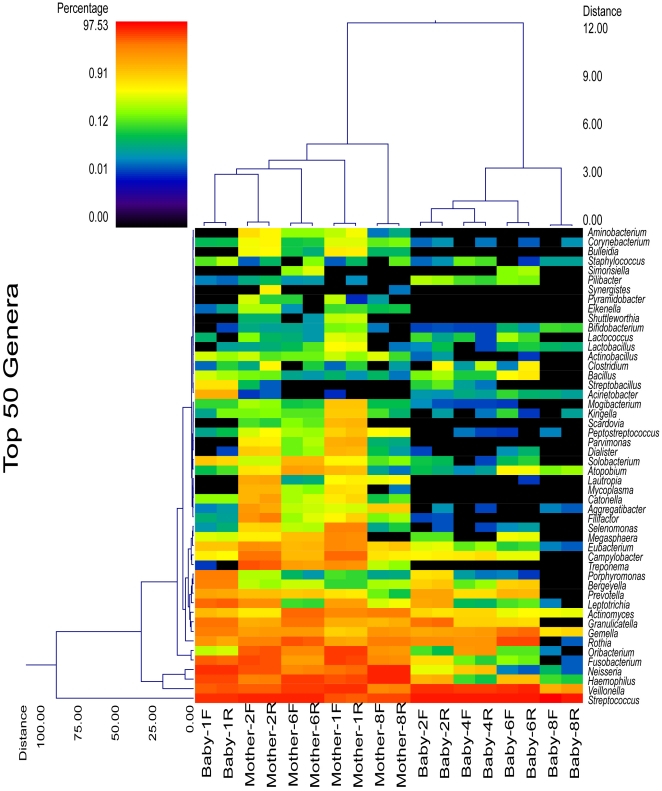
Dual hierarchical clustering dendogram of the most predominant and ubiquitous 50 bacterial genera among the samples.Baby and mother number and sequence direction [forward (F); reverse(R)] are provided on the bottom x-axis. Those genera that occurred in only 1 sample were omitted, along with those present in relative average percentages<0.09% in 3 or fewer samples. The genera that occurred in average percentages <0.01% among all samples were also excluded. It should be noted that inclusion of all genera did not change the clustering patterns (data not shown), thus this analysis accurately represents and overview and relationship among samples for the microbiome data. The dendogram provides the genus designation along the right y axis and the abundance relationship across all samples for each genus based upon Wards clustering and Manhattan distance methods along the left y-axis. The relative distance scale for the left y-axis is provided in the lower left corner of the figure. The samples have also been clustered based upon Wards and Manhattan principles with sample designations along the bottom x-axis and the clustering described along the top x-axis in the figure. The heatmap depicts the relative percentage of each genus for each sample. The color scale for the heatmap is shown in the upper left corner of the figure.